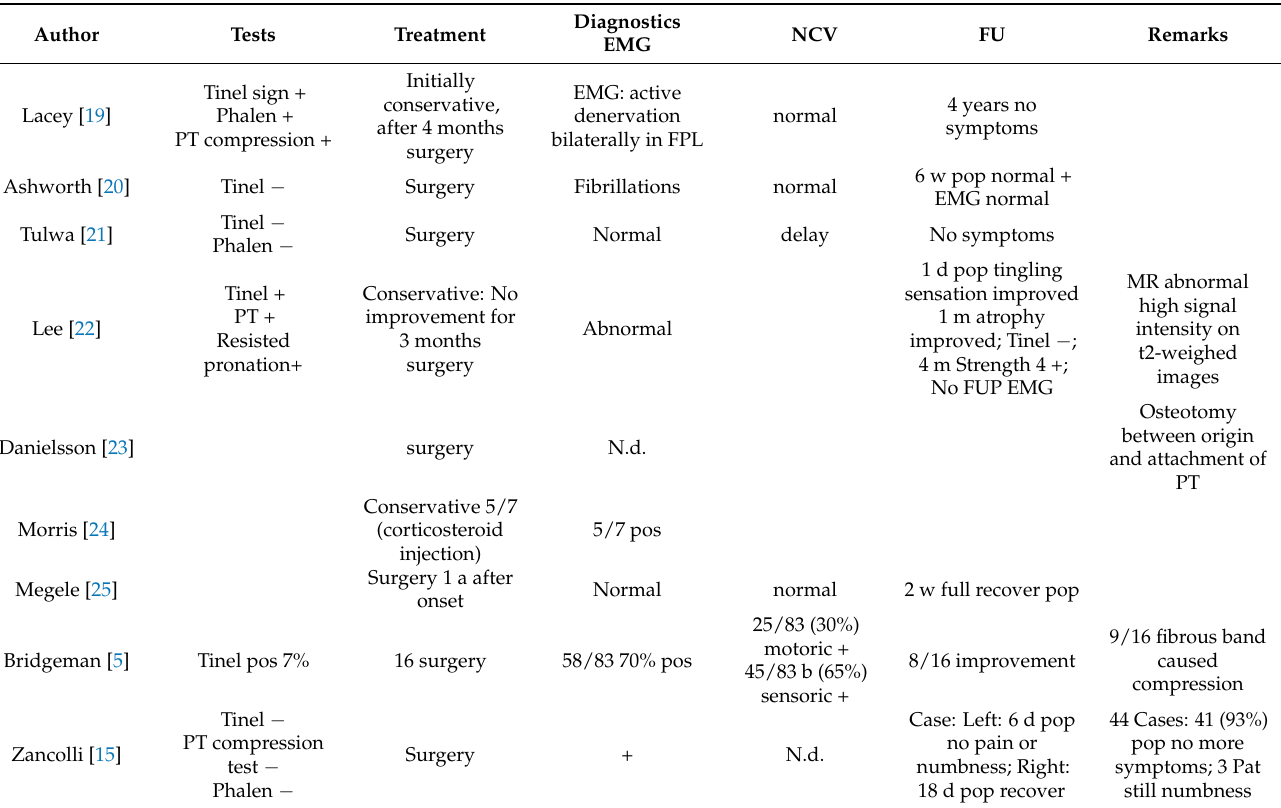
Table 5. Overview of Diagnostics—literature